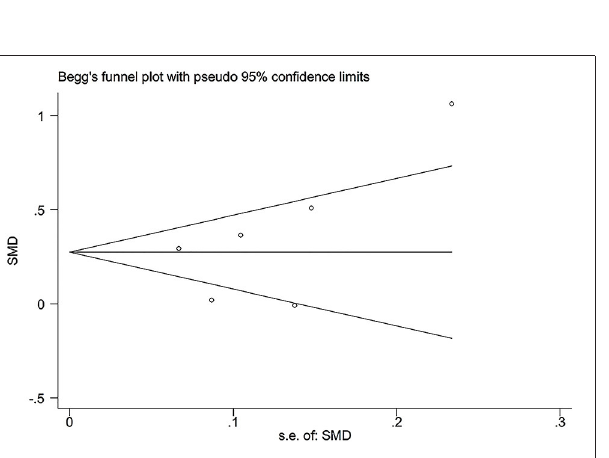
It is not difficult to speculate that the positive correlation between the rs2910164 polymorphism and CAD (Liu et al., 2017; Zhou et al., 2017) was mediated, at least partly, by